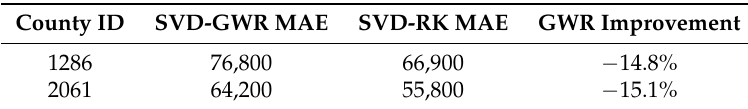
Table 8. GWR over SVD-RK in